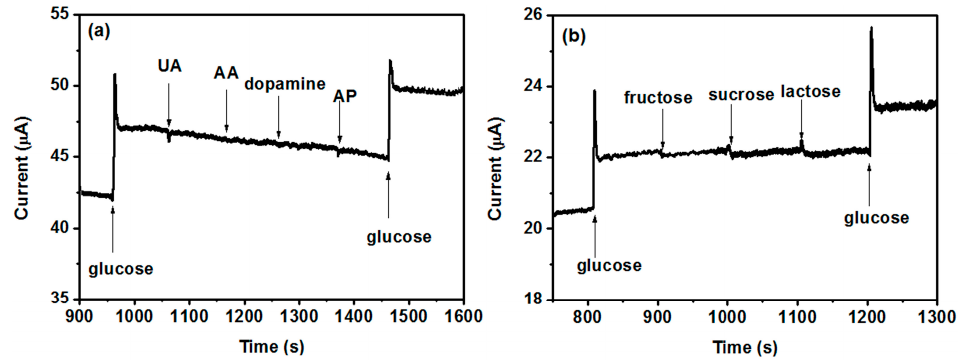
Figure 10. ( a ) Interference test of CeO 2 /Ni(OH) 2 /CPE upon continuous adding 5 mM glucose, 0.1 mM UA, 0.1 mM AA, 0.1 mM dopamine, 0.1 mM AP, and 5 mM glucose at 0.55 V in 0.1 M NaOH solution; ( b ) Interference test of CeO 2 /Ni(OH) 2 /CPE upon continuous adding 5 mM glucose, 0.1 mM fructose, 0.1 mM sucrose, 0.1 mM lactose, and 5 mM glucose at 0.55 V in 0.1 M NaOH solution.